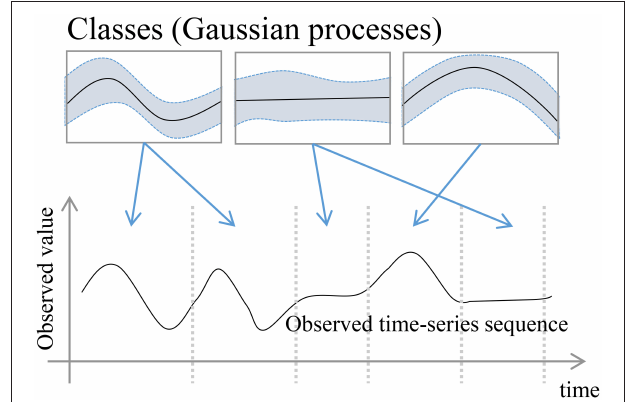
FIGURE 1 | Overview of the proposed